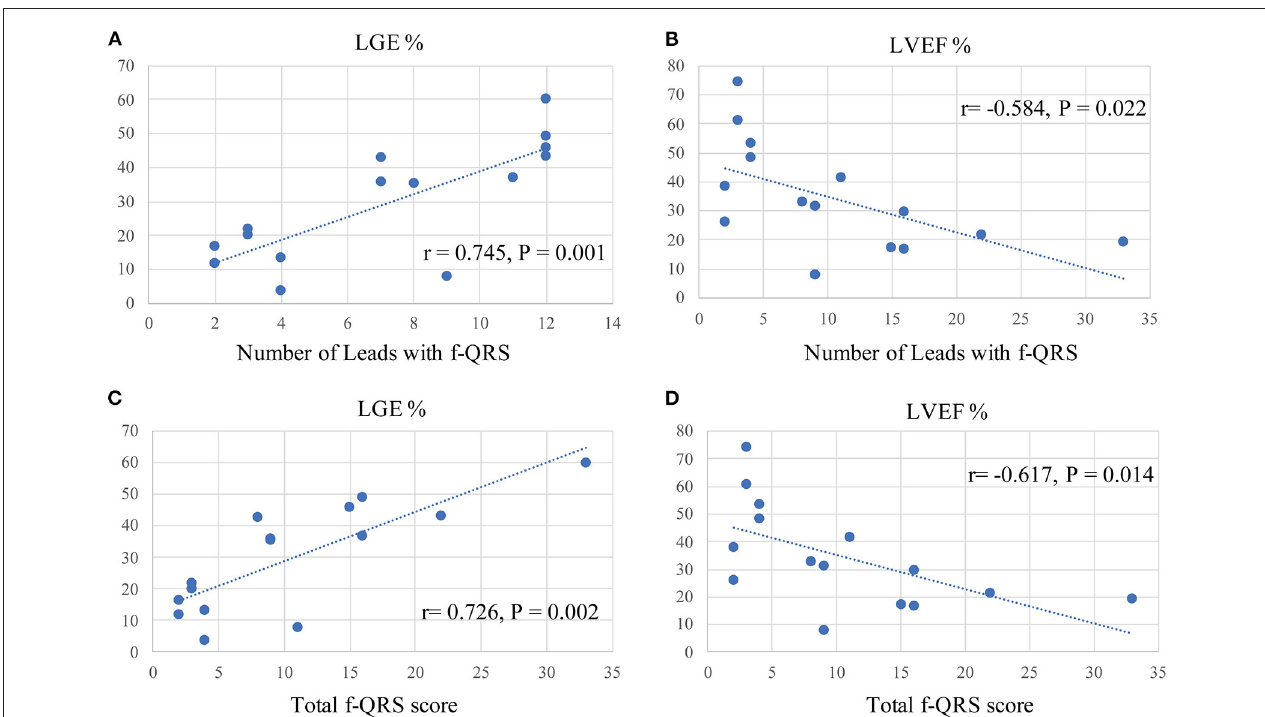
FIGURE 2 | Spearman correlation analysis between f-QRS and CMR parameters in our Danon disease cohort. f-QRS, fragmented QRS; LGE, late gadolinium enhancement. (A) Correlation between the number of leads with f-QRS and LGE% ( r = 0.745, p = 0.001). (B) Correlation between the number of leads with f-QRS and LVEF% ( r = − 0.584, p = 0.022). (C) Correlation between the number of leads with f-QRS and LGE% ( r = 0.726, p = 0.002). (D) Correlation between f-QRS score with f-QRS and LVEF% ( r = − 0.617, p = 0.014).